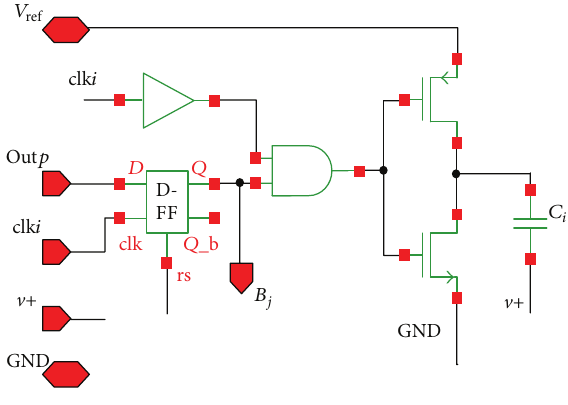
Figure 11: Typical subblock in